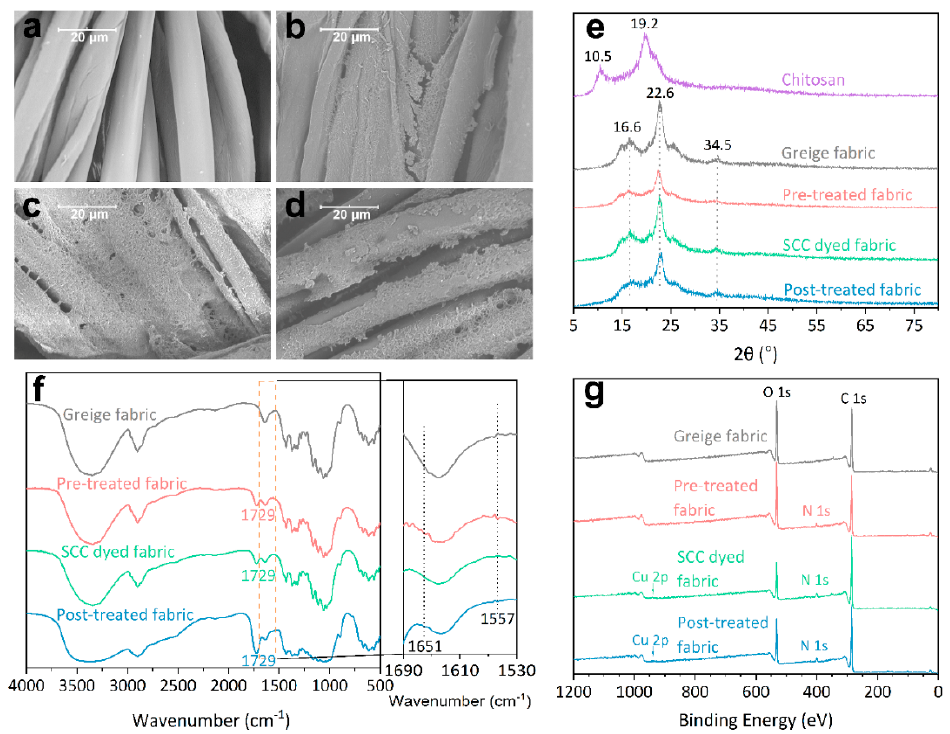
Figure 6. SEM images of ( a ) greige fabric, ( b ) pre-treated fabric, ( c ) SCC-dyed fabric and ( d ) post-treated fabric; and ( e ) XRD, ( f ) FTIR and ( g ) XPS wide-scan spectra of the four samples. Δ E of the SCC-dyed fabric was calculated after post-treatment to determine whether treatment resulted in a color change. The Δ E of all samples exceeded 2, indicating the treatment caused a visible